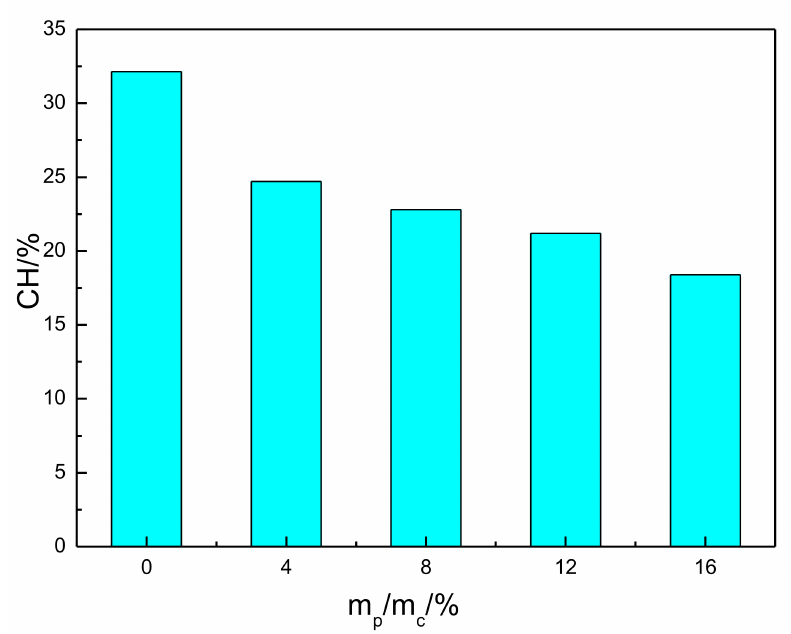
Figure 9. Calcium hydroxide content of EVA-Modified cement